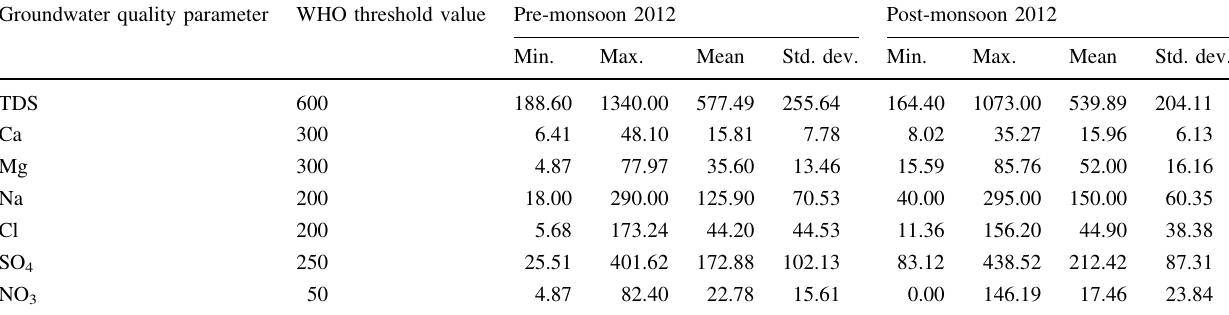
Table 2 Statistics of the selected groundwater quality parameters with the respective WHO maximum desirable limits (all values are in milligrams per liter (mg/l))